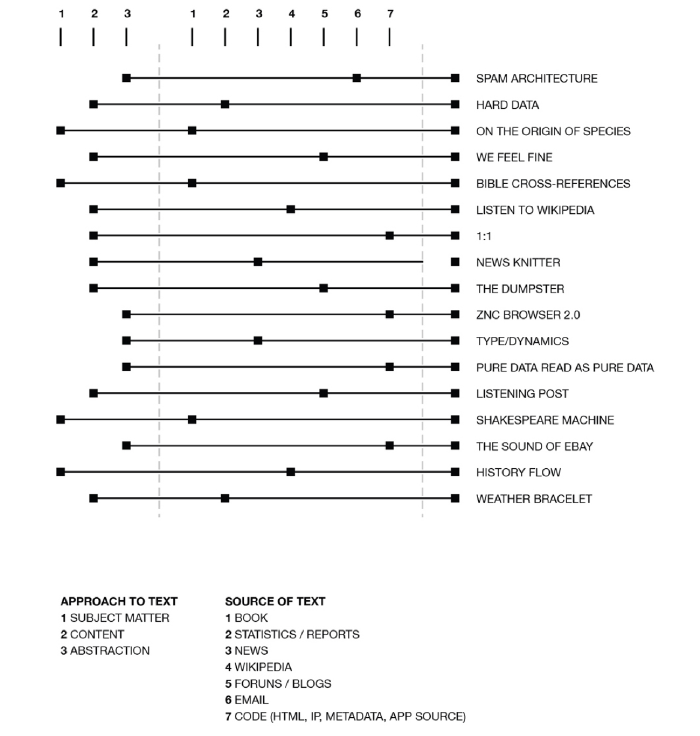
Figure 1 | Analysis graph: conceptual dimension – observation of artwork’s theme and